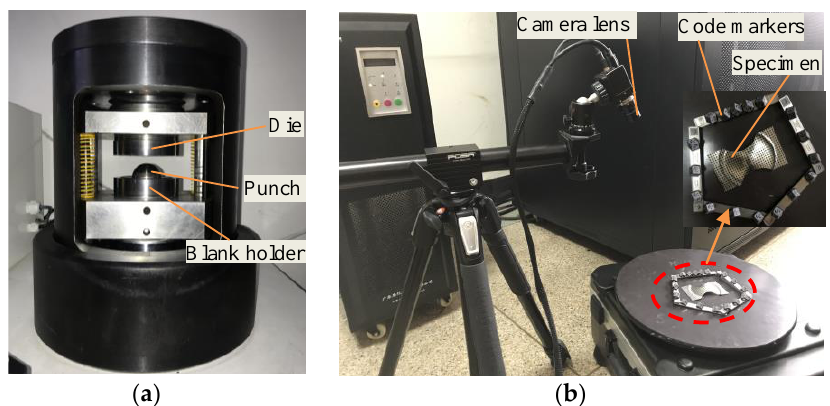
Figure 7. Test equipment. ( a ) Punch-stretch test equipment. ( b ) Optical strain measurement system.